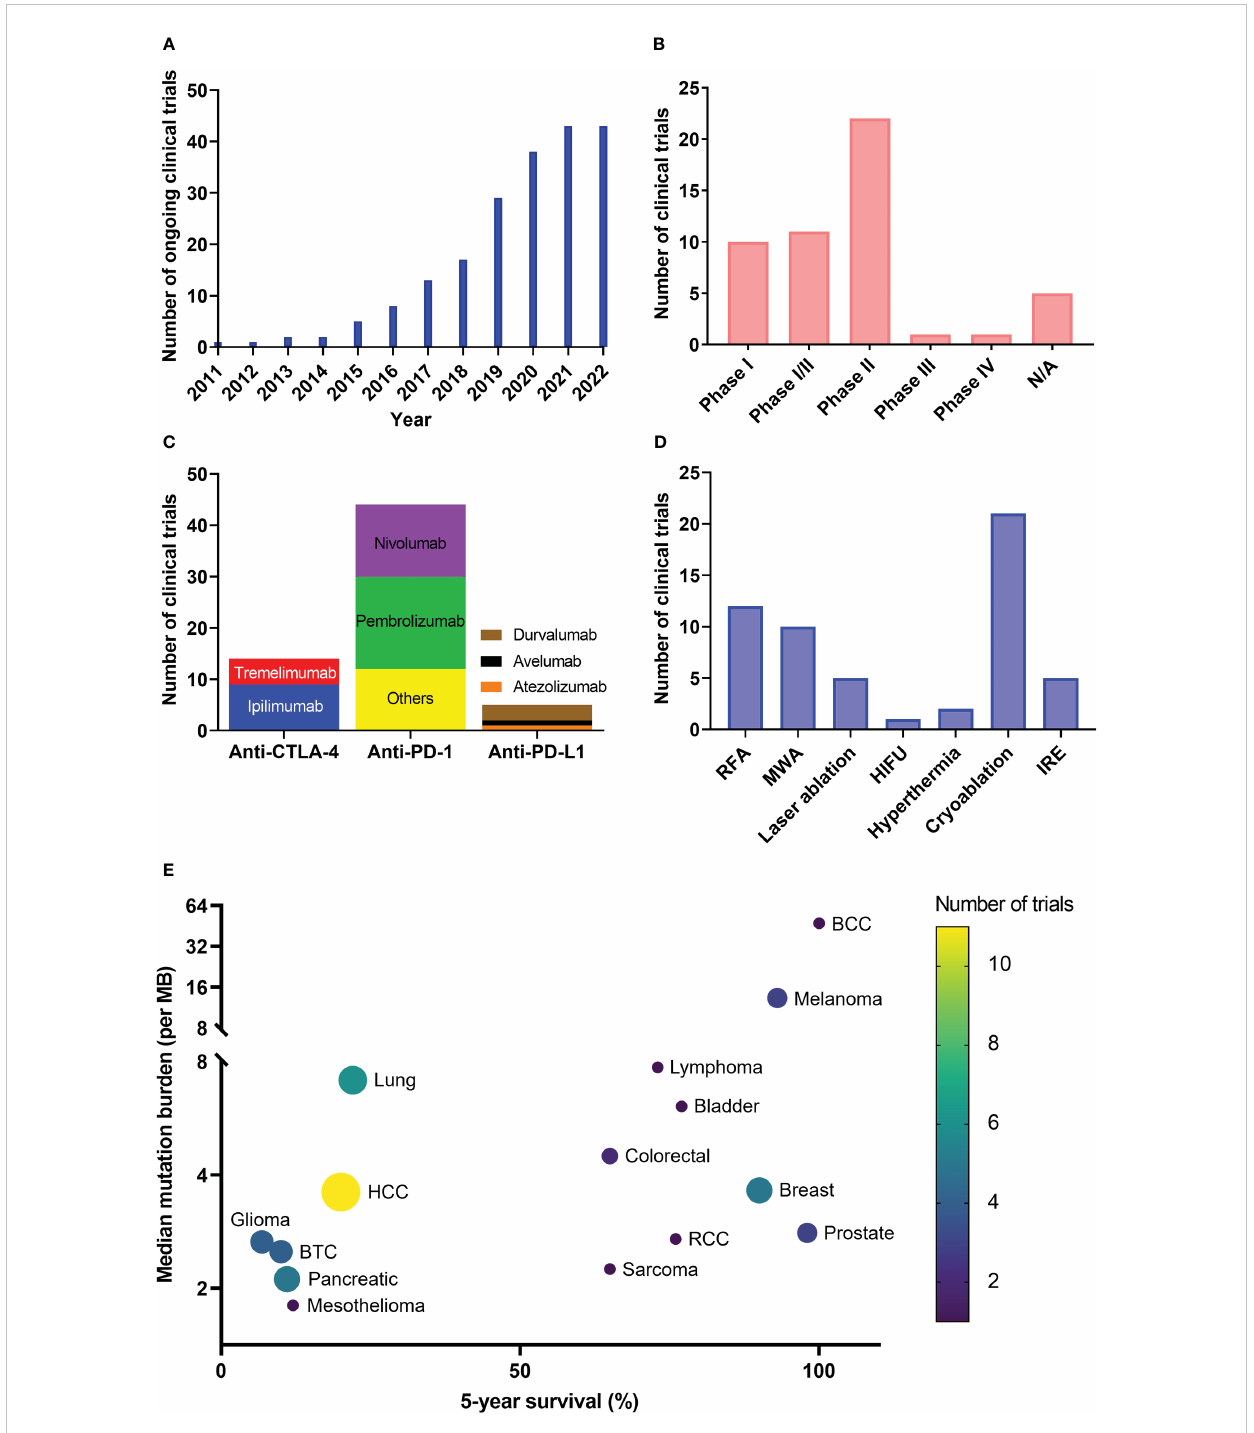
FIGURE 3 Clinical trial summary. The numbers of clinical trials are grouped by year (A) , clinical phase (B) , use of ICI drug (C) , focal therapy modality (D) and targeted diseases with their tumor mutation burden and 5-year survival (E) . BCC, basal cell carcinoma; BTC, biliary tract carcinoma; HCC, hepatocellular carcinoma; RCC, renal cell